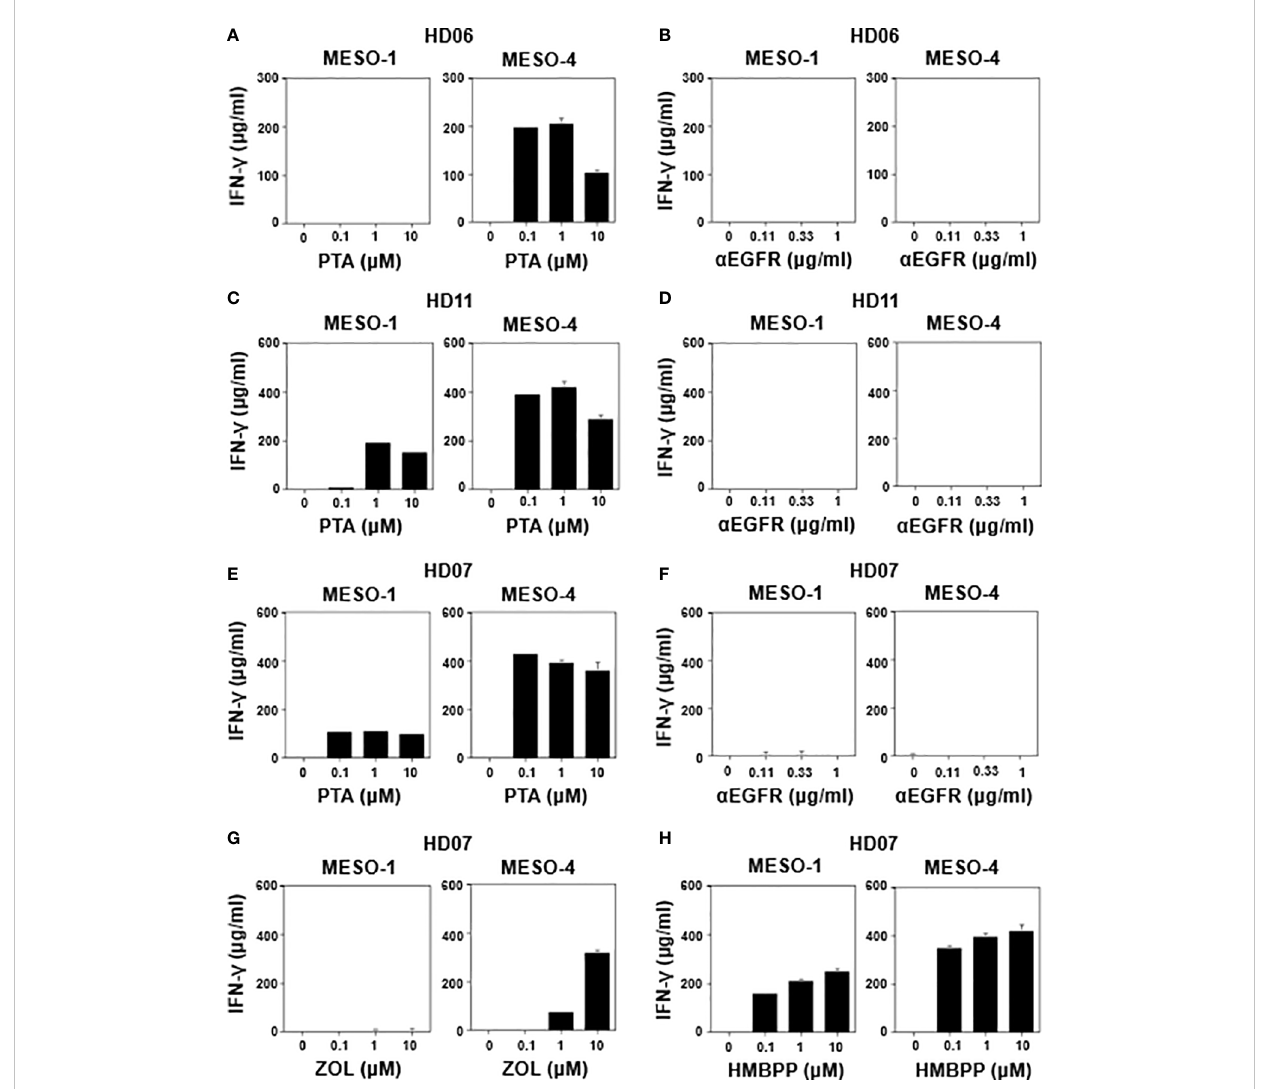
FIGURE 3 Effect of gd T cell stimulants on the induction of IFN- g secretion. MESO-1 or MESO-4 cells (2 x 10 4 cells) were incubated with gd T cells (1.6 x 10 6 cells) derived from healthy donors (HD06 (A, B) , HD11 (C, D) , and HD07 (E – H) ) in the presence of serial dilutions of stimulants (PTA (A, C, E) , ZOL (G) , HMBPP (H) , or anti-EGFR mAb (B, D, F) ) at 37 °C for 48 h and the supernatants were examined for IFN- g through